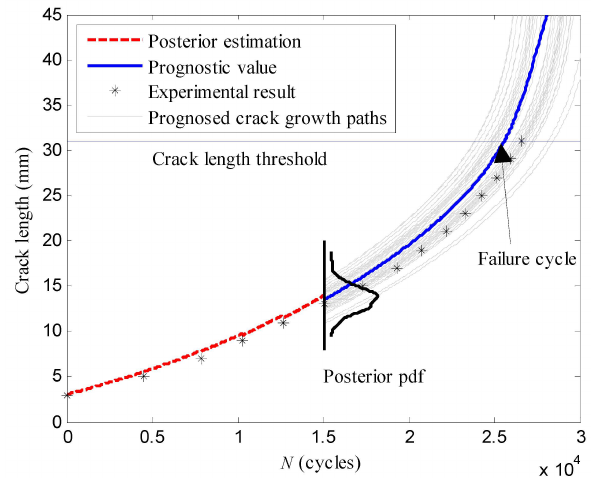
Figure 12. The estimation and prognosis procedures of the crack length with the LW-PF.